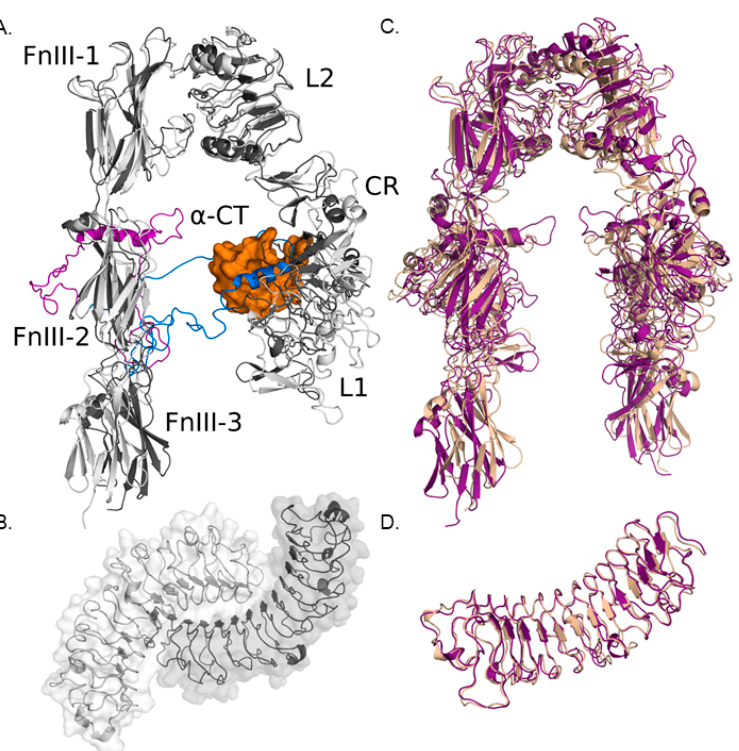
Figure 3. IGF-IR and biglycan models. ( A ) Aligned cartoon models of ectodomain monomers of apo-IGF-IR (in grey and purple) and IGF-IR complexed with IGF-I (in white and blue with IGF-I as orange surface). The colored loop regions are homology models from PDB IDs 5U8R and 5U8Q for apo-IGF-IR and IGF-IR complexed with IGF-I, respectively, created with SWISSMODEL [43]. ( B ) Bovine biglycan dimer (PDB ID 2FT3): the concave core region is unavailable for forming other interactions when biglycan is dimerized. ( C , D ) Aligned cartoon models of first (sand) and last (purple) frames from the 1 ns MD trajectory of the apo-IGF-IR and the human biglycan monomer models. The structures corresponding to the last frames were submitted to the ClusPro server for docking.